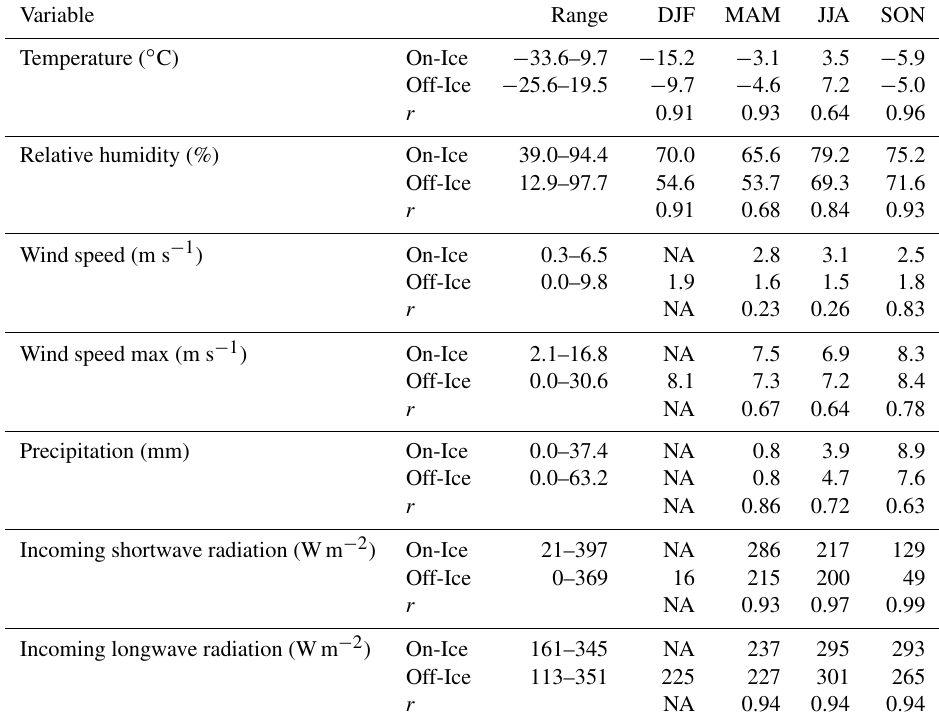
Table 2. Seasonal means of meteorological variables for the On-Ice and Off-Ice stations based on data between 18 April 2013 and 6 Septem- ber 2014. All data are for times when both stations were operating, so these data do not represent full season averages. Data were excluded from the period when the On-Ice station was buried by snow: 18 January to 22 April 2014. Correlations for precipitation excluded days when both stations had no precipitation. NA denotes no data were